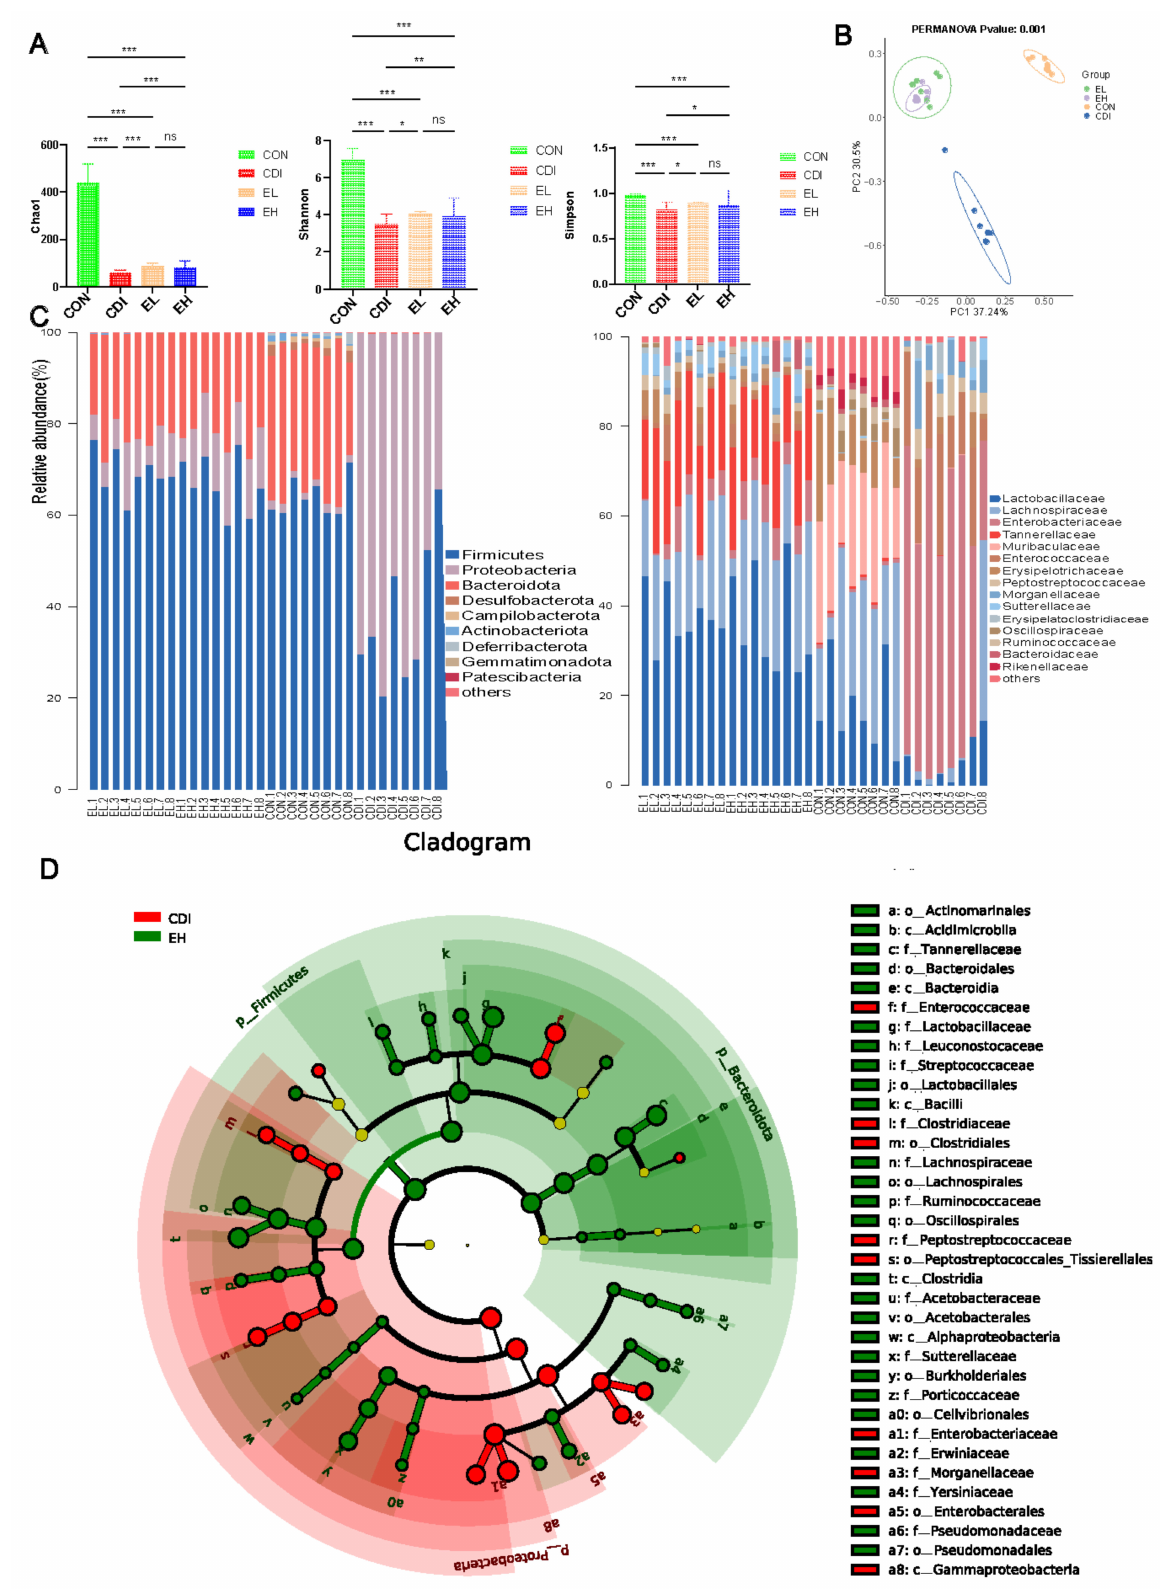
Figure 4. Modulation of the intestinal flora in C. difficile -infected mice by EGCG. ( A ) α -Diversity. ( B ) β -Diversity. ( C ) Relative levels of the most abundant taxa at the phylum and family levels. ( D ) LEfSe analysis of the EH and CDI groups. *, p < 0.05; **, p < 0.01; ***, p < 0.001; ns, p >